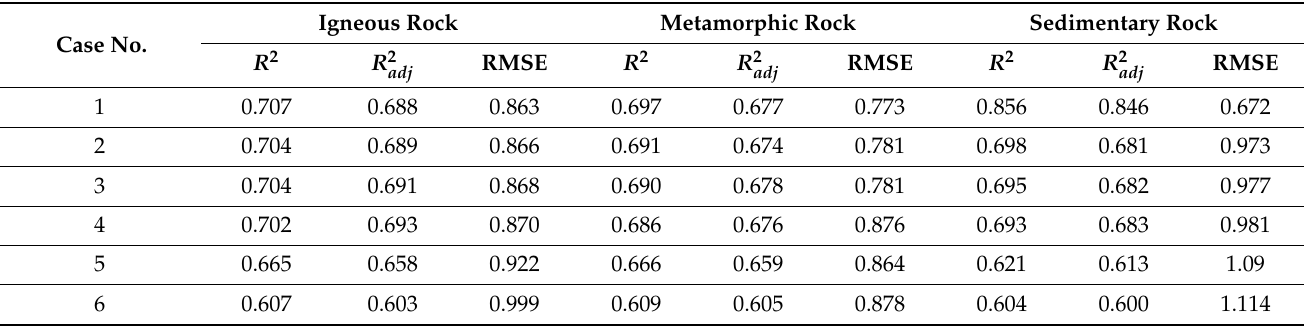
Table 3. The results of the multi-collinearity analysis.